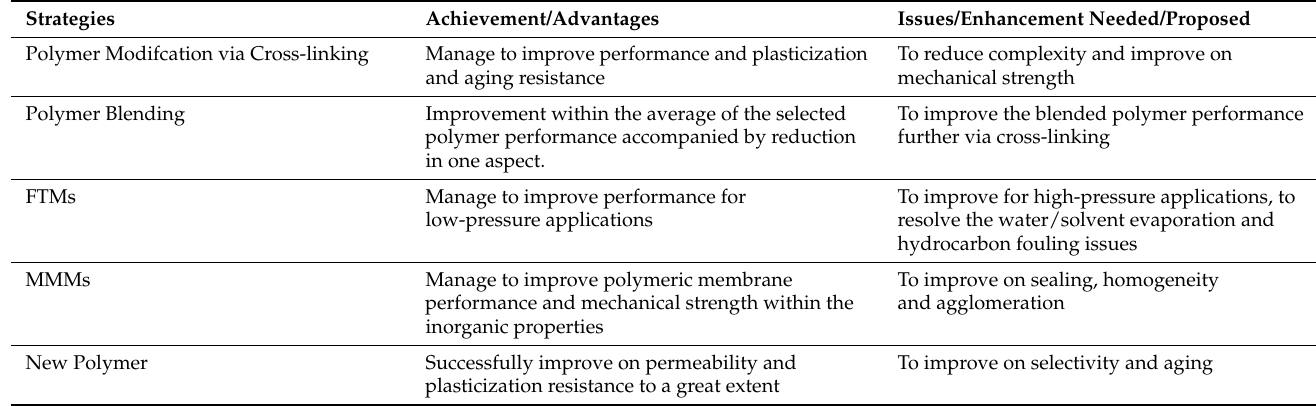
Table 8. Summary of recent polymeric gas-separation (CO 2 /CH 4 ) membrane improvement strategies for plasticization and aging